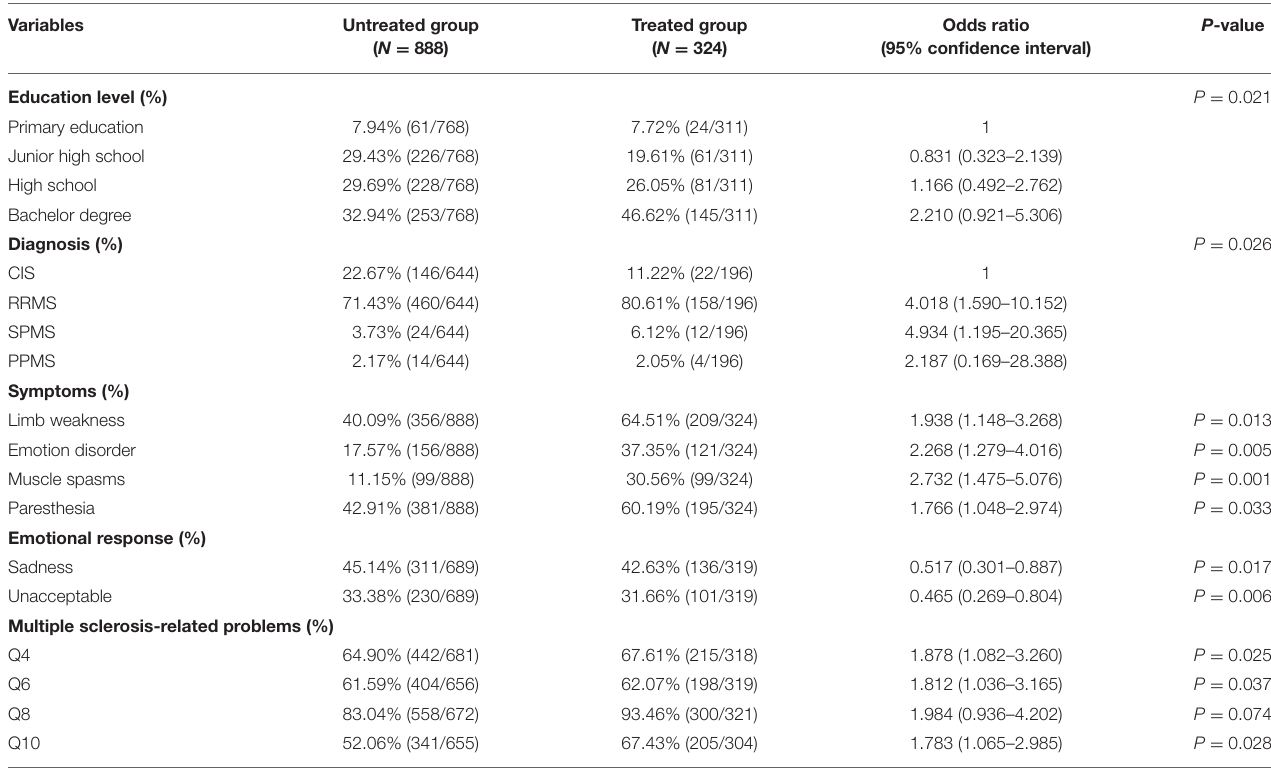
TABLE 3 | Multivariate logistic regression model of all indicators between the treated group and untreated group. Variables Untreated group